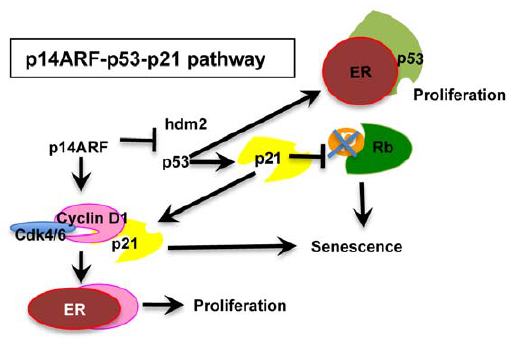
Figure 9. Escape from p14ARF cell cycle arrest (premature senescence in MCF-7 breast cancer cells): A proposed model. P14ARF binds hdm2 and sequesters it to the nucleolus. P53 upregulates p21 and p21 dephosphorylates and downregulates Rb. P21 also binds and inactivates cyclin D1/cdk4/6 complex and induces premature senescence. Two avenues are suggested whereby cells may escape from senescence: ER binds p53 and inactivates p14ARF-p53 inhibitory functions [44]; alternatively ER binds to cyclin D1 with a gain of cell proliferative function [40]. 488 for a further 30 min as described by the manufacturer. Cells were counterstained with Hoechst 33342 (1:1000) in PBS before